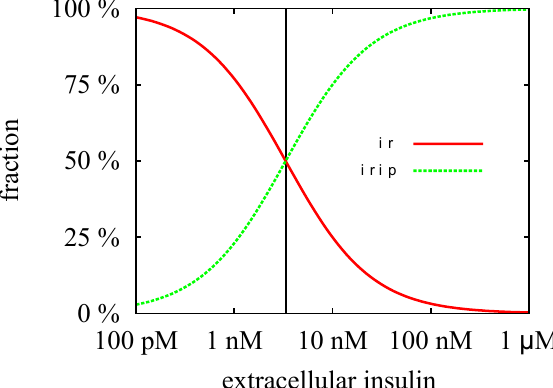
Figure 8. The fractions of the steady-state concentrations, ir ∗ /ir and irip ∗ /ir , are plotted 0 0 versus the concentration of the external insulin. The vertical line indicates the value of the = 3 . 33 nM. For insulin concentration above i equilibrium constant, i , more than 50 % of c c the extracellular IR binds an insulin molecule. All the IR becomes saturated for an insulin = 3 . 33 concentration which is large compared to i , i.e. , for i (cid:29) i c c